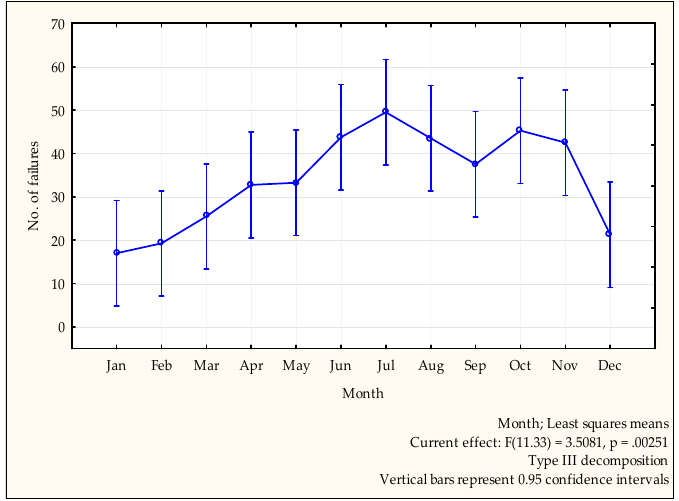
Vertical bars represent 0.95 confidence Figure 3. Failure averages. Figure 3. Failure averages.